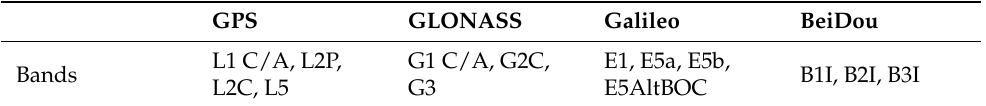
Table 1. Global navigation satellite system (GNSS) signals tracked by reference stations in the Testbed in Aarhus for Precision Positioning and Autonomous Systems (TAPAS) network. GPS GLONASS Galileo BeiDou L1 C/A, L2P, Bands L2C,